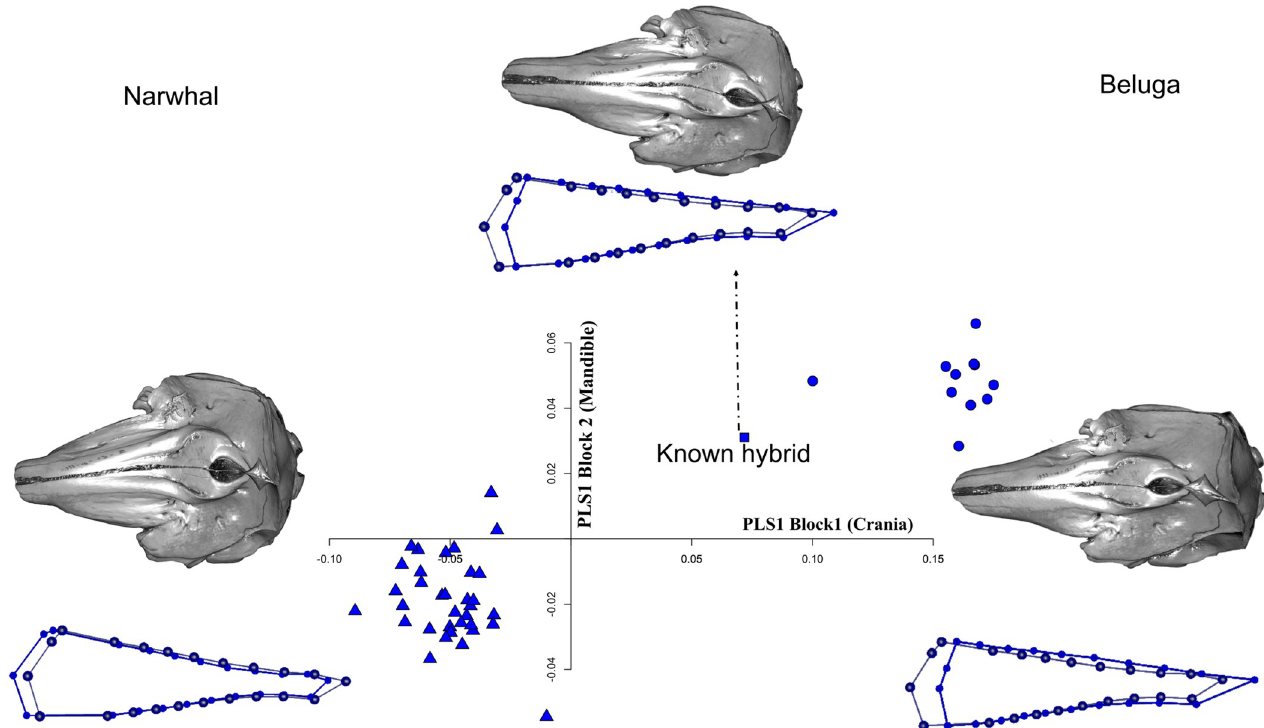
Fig 7. Skull integration. Scatter plot of the partial least square axis 1 (PLS1) of block1 (cranium) and block2 (mandible) of the Monodontidae. Shape differences can be viewed by 3D cranium warping and wireframe for the hemi-mandible; the light colour refers to the mean shape of the individuals, whereas the dark colour refers to extreme-most individual on the PLS1 axes. Correlation is 0.902. The dotted line indicates the hybrid warping and